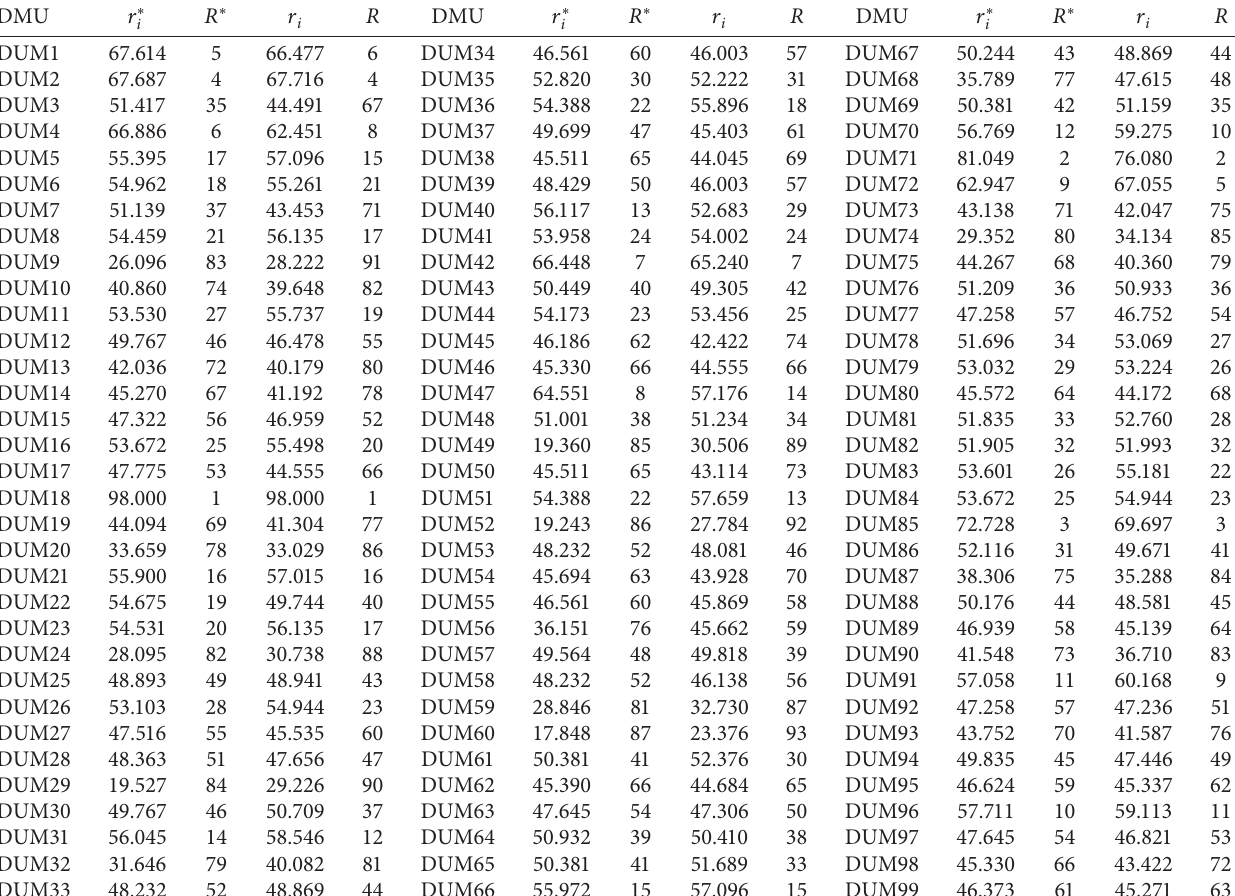
Table 4: The sum values of the degree of preference and ranks of the